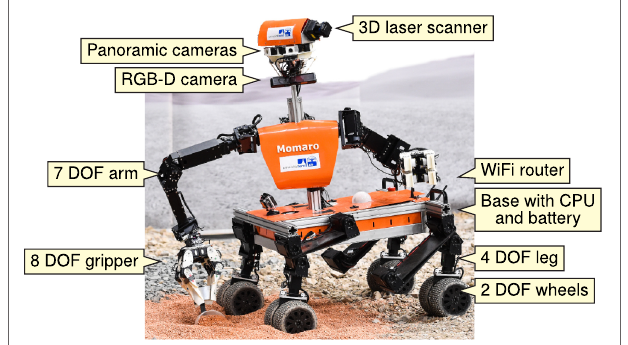
FIGURE 1 | The mobile manipulation robot Momaro taking a soil sample